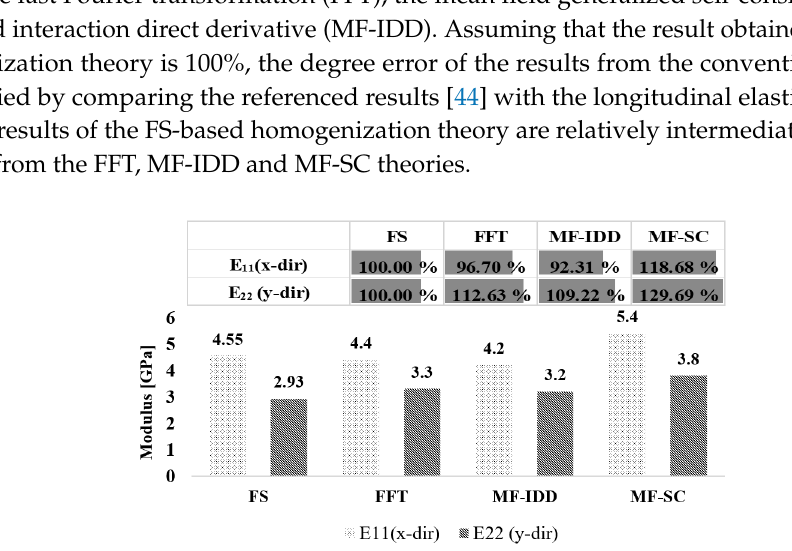
( b ) Figure 6. Analysis image of GDL structure at 30% and 50% compression: ( a ) 30% compressed GDL; ( b ) 50% compressed GDL.